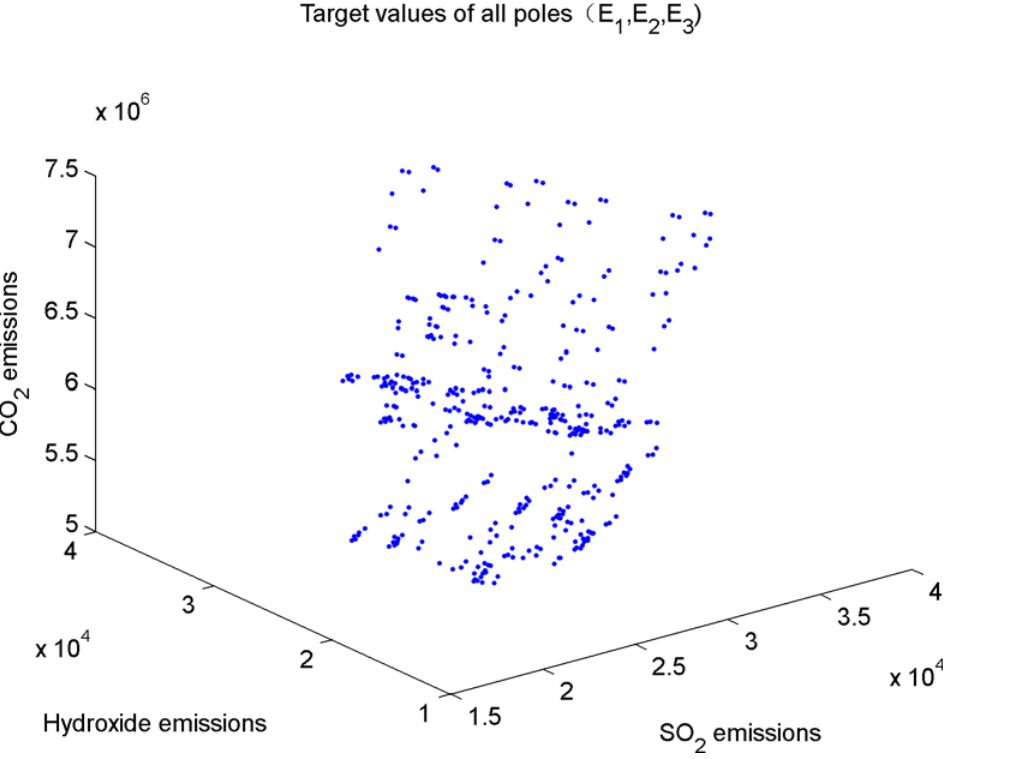
Fig 2. Target values of all